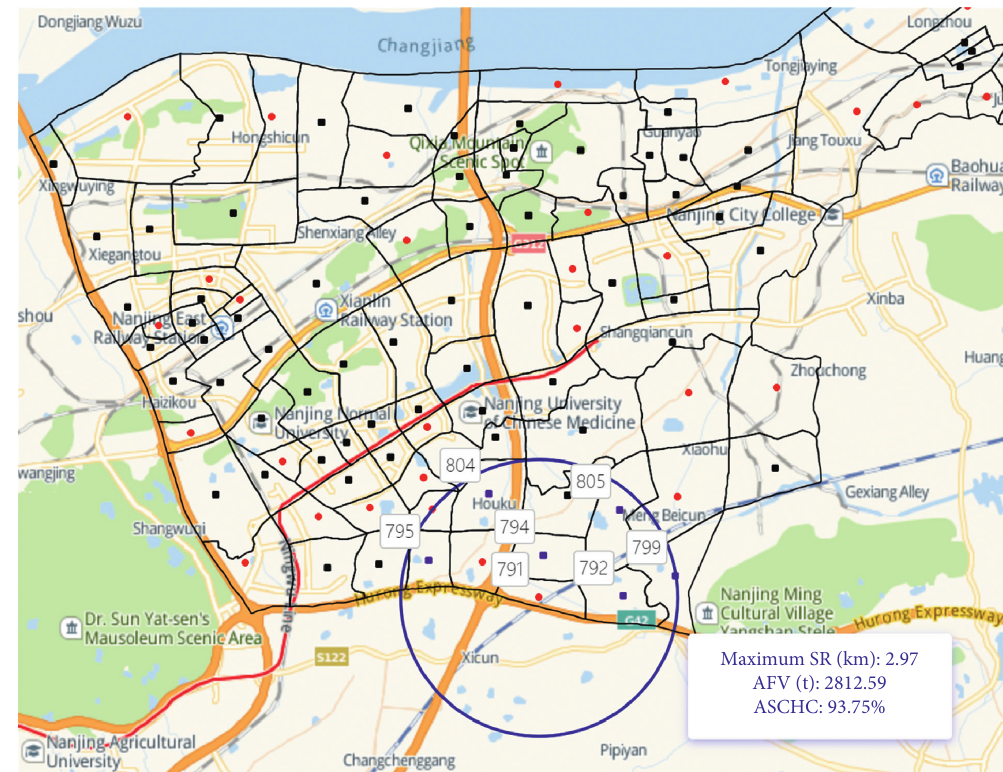
Figure 6: Distribution of SHs obtained using the ACO. Table 1: Solutions to the SCP obtained using the